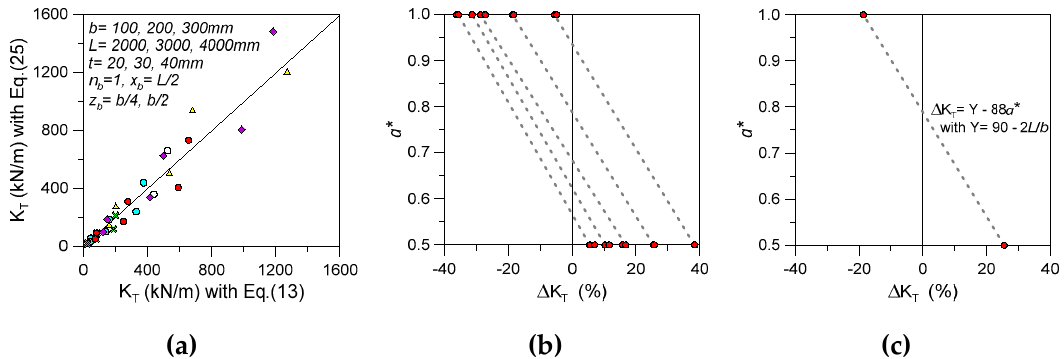
Figure 12. Comparative calculation of threshold stiffness K T for LR glass beams, with evidence of ( a ) expected accuracy, ( b ) corresponding percentage scatter Δ K T deriving from the adapted calculation approach (Equation (25), with selected results grouped by L / b and a *), and ( c ) correction proposal.